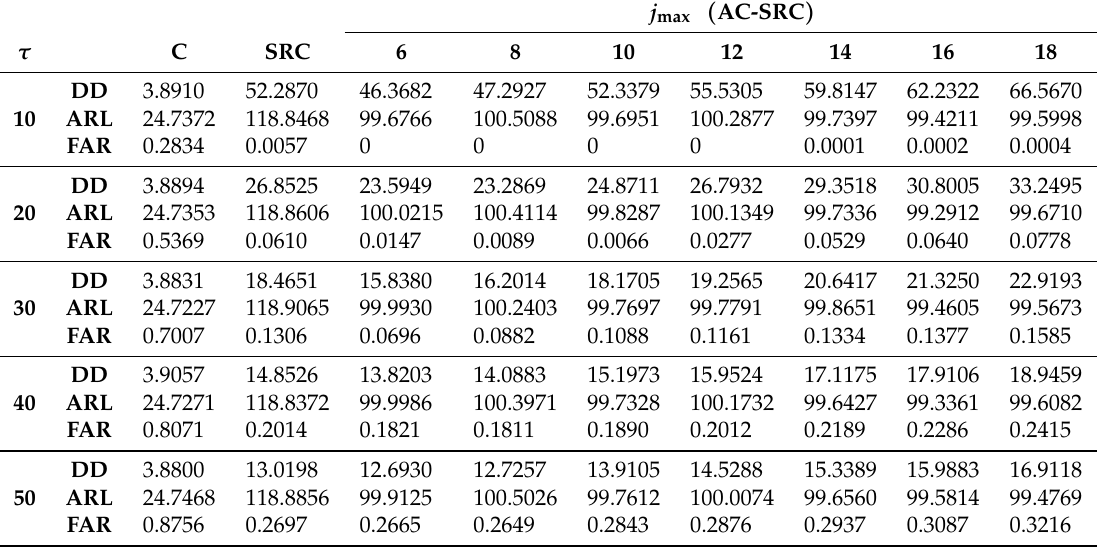
Table 5. ARL 0 = 100, 10%